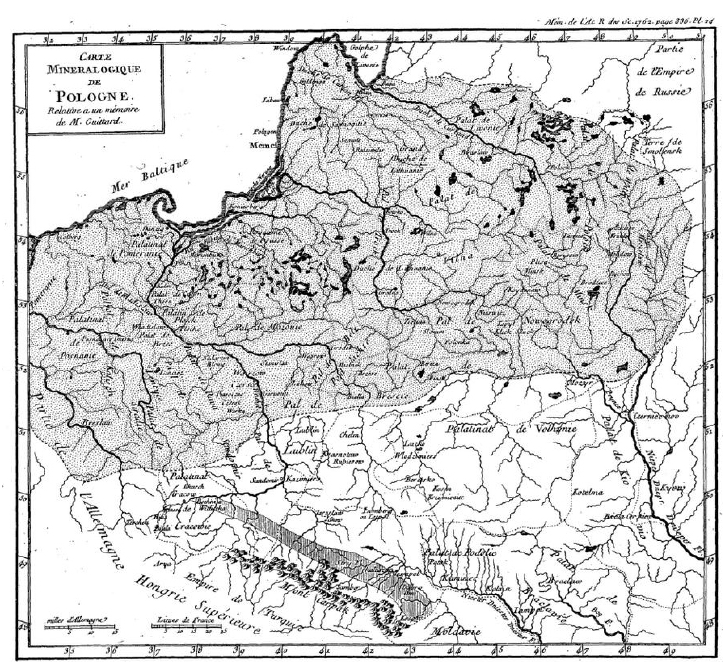
Fig. 7. Map Carte Minéralogique de Pologne by J.-É. Guettard, 1764